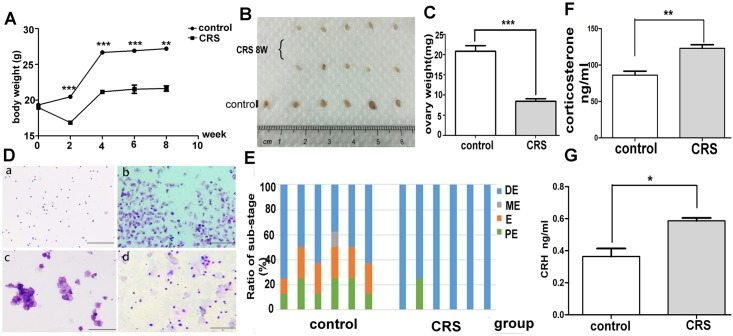
CRS reduced the body weight of mice and caused deregulation of the estrous cycle.(A) CRS reduced the body weight of mice (n = 10, P< 0.05). (B) The ovarian gross morphology of the control and CRS 8w groups. The size of the control group was almost two times larger than that of the CRS group. (C) The ovarian weight was significantly decreased in the CRS 8w group compared with the control group (n = 6, P< 0.001). (D) The morphological characterization of the smears in every substage of the mice estrum cycle. Briefly, three types of cells were present in the smear, including small leukocytes, larger and round epithelial cells, and large, flat, and nonnuclear cornified cells. The relative numbers of leukocytes (L) and epithelial (E) and cornified (C) cells in the vaginal smear indicated the stage of the estrous cycle. (a) Contained L and was classified as diestrum (DE). (b) Contained E and was classified as proestrum(PE). (c) Contained C and was classified as estrum (E). (d) Contained three types of cells and was classified as metaestrum (ME). (Bar = 100μm) (E) CRS caused deregulation of the estrous cycles of mice, and the CRS 8w group remained in the diestrum stage almost throughout the cycle (n = 6; PE, proestrum; E, estrum; ME, metaestrum; DE, diestrum). (F) Serum corticosterone level of mice in both control and CRS 8w groups (n = 10, P< 0.001). (G) Serum concentration of CRH in mice of both control and CRS 8w groups (n = 10, P< 0.05). CRS, Chronic restraint stress.